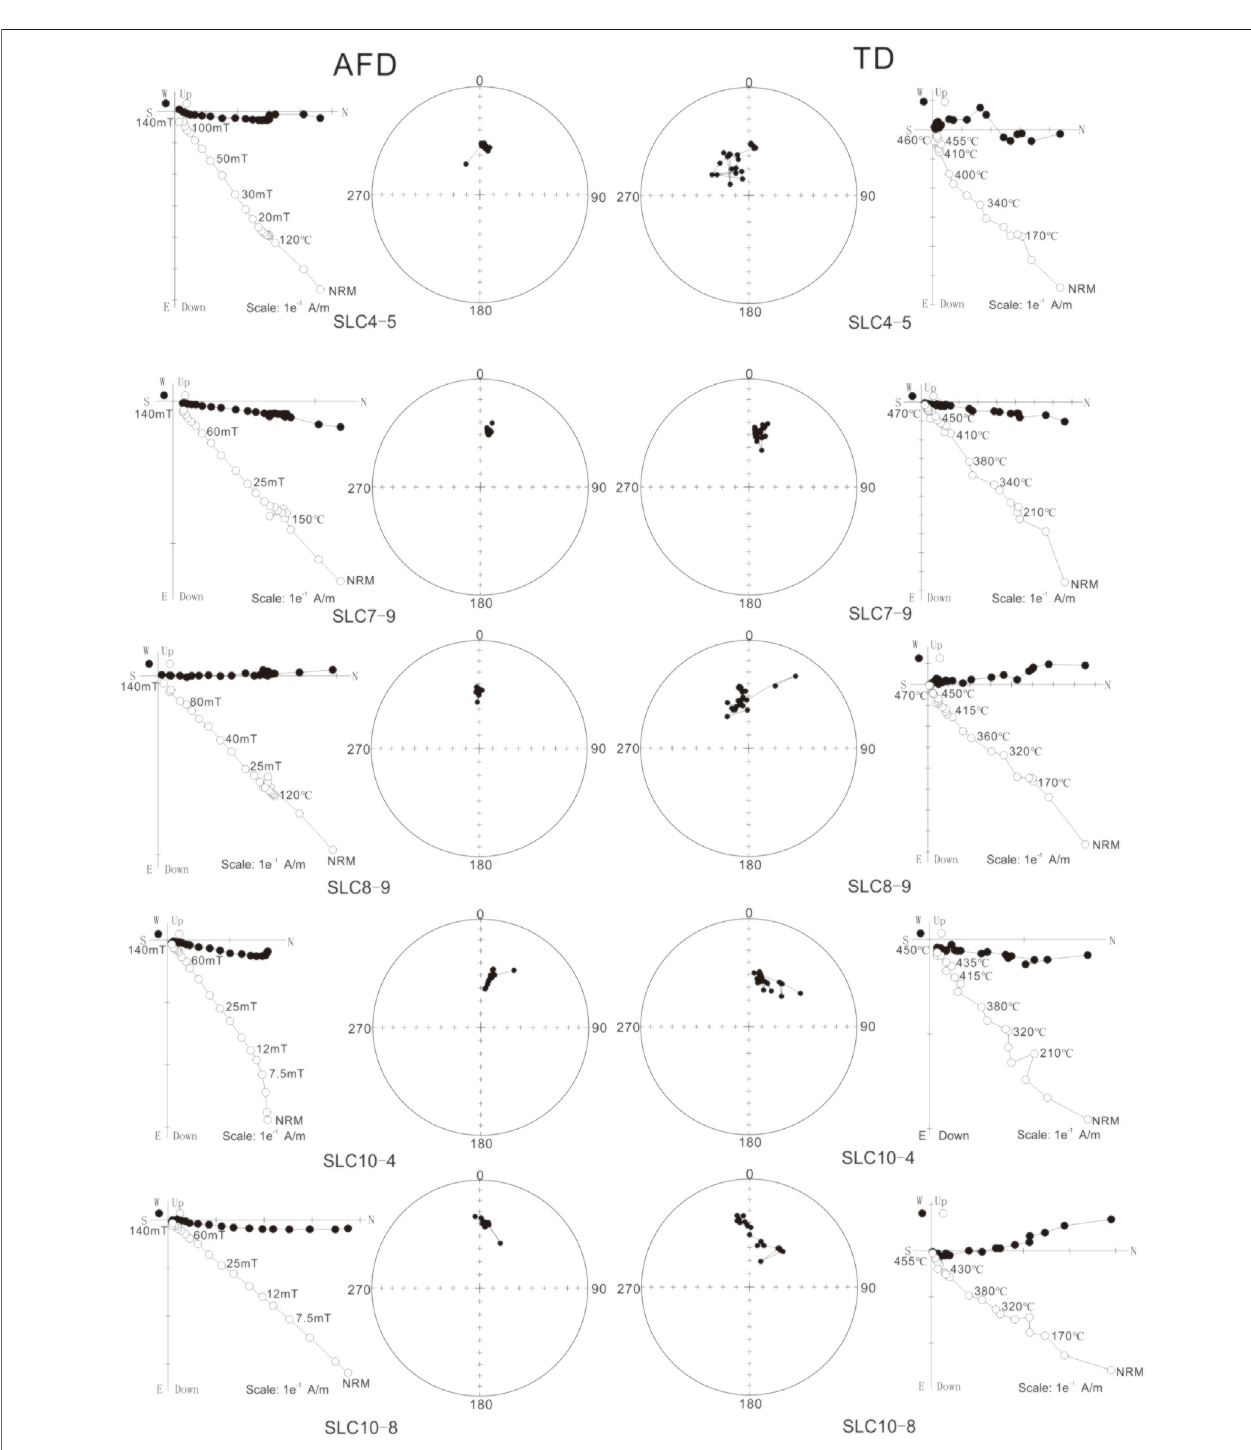
FIGURE 8 | Representative orthogonal vector plots and equal-area projections of the Upper limestone ZD Formation in geographic coordinates. Thermal/ alternating fi elddemagnetization(TD/AFD)steps arein ° C/mT. Open/solid circlesrepresentvertical/horizontal planeprojectionsinthe orthogonaldiagramsand upward/ downward inclinations in the stereonet diagrams.